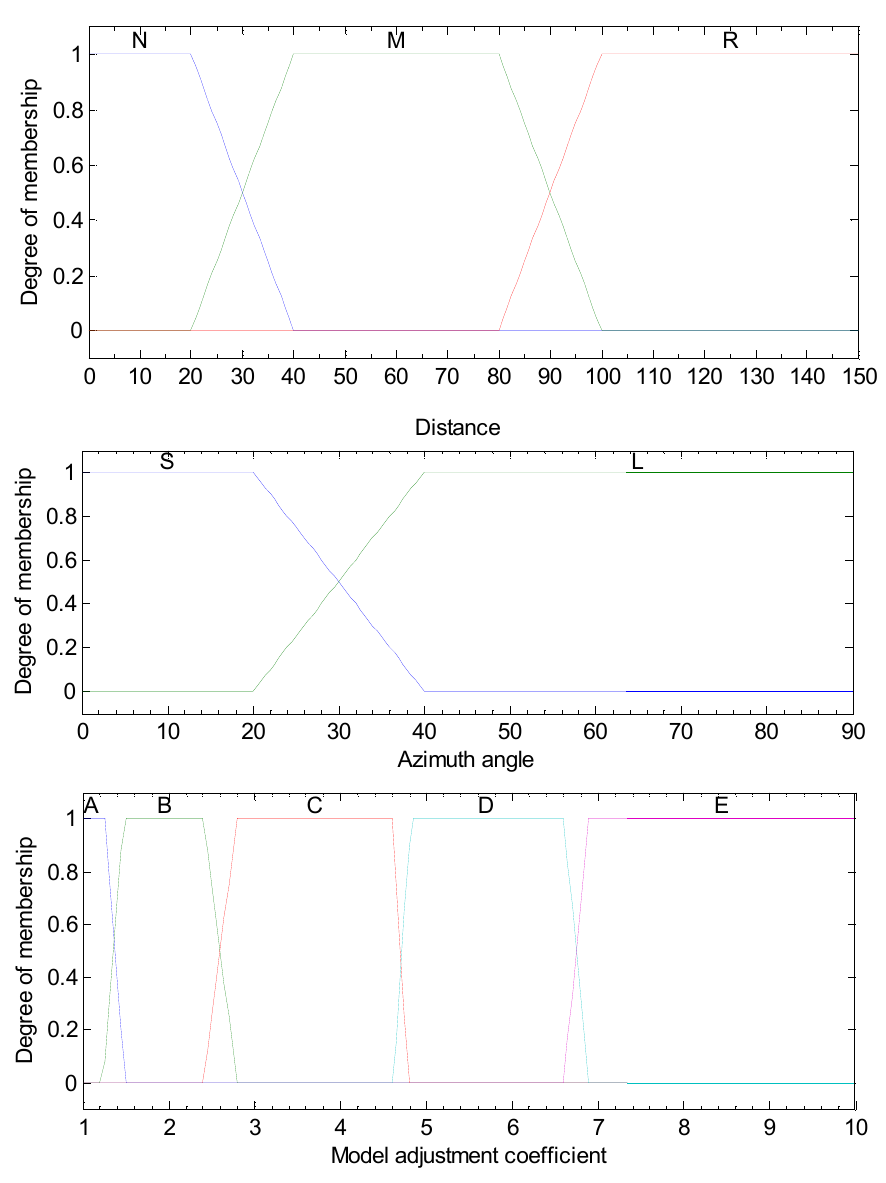
Figure 4. Membership functions for d i and α i .